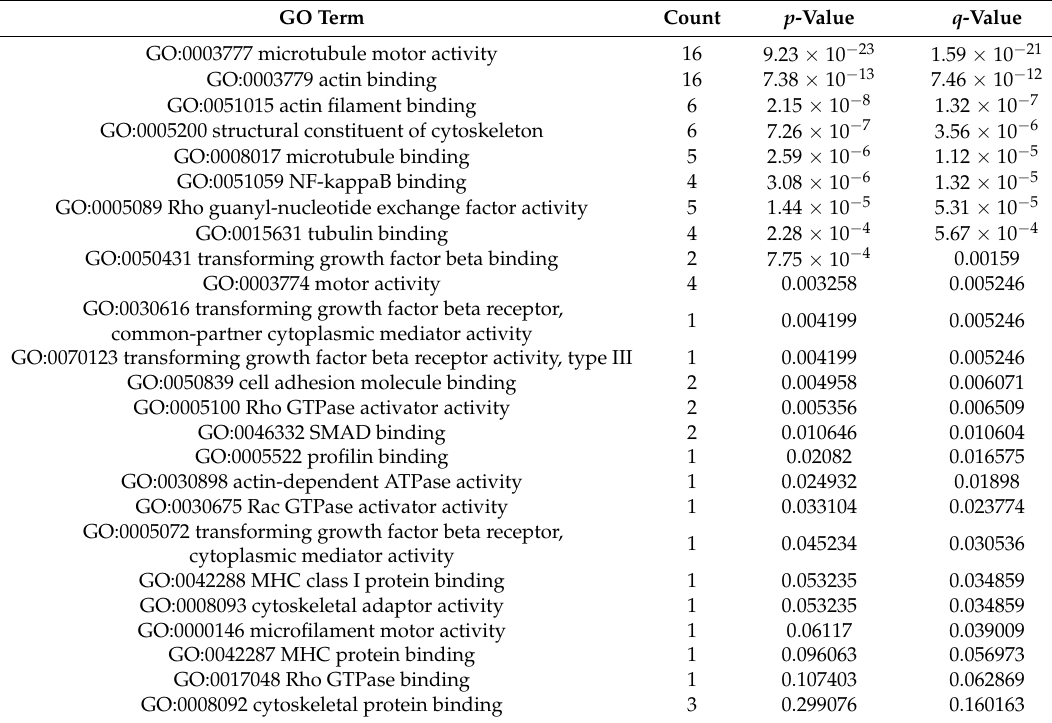
Table 2. GO term analysis of the upregulated genes.